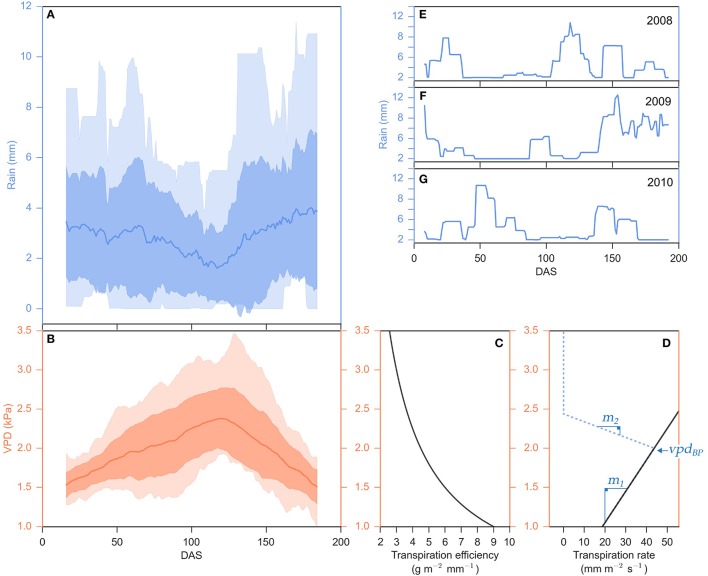
Seasonal fluctuations of rainfall and VPD and their relationship to sorghum transpiration rate and efficiency. (A,B) Distribution of daily rainfall (mm) and daily vapor pressure deficit, VPD, (kPa) over the 2000–2014 cropping seasons in College Station, TX, calculated as a mean of a 30-day sliding window. The mean is plotted as a solid line, the lighter transparent fill is the entire data range (minimums and maximums) and the darker transparent fill is one standard deviation from the mean. (E–G) Distribution of daily rainfall (mm) for the 2008 (E), 2009 (F), and 2010 (G) cropping seasons in College Station, TX, calculated as a mean of a 14-day sliding window. (C) Transpiration efficiency, biomass produced per unit of water transpired (g m−2 mm−2), and (D) a hypothetical transpiration rate (solid black line), the amount of water uptake per unit time (mm m−2 s−2), and their responses to VPD (kPa) are plotted along the x-axes sharing the y-axis of panel (B). VPD-limited transpiration trait parameters {vpdBP, m1, m2} is denoted in blue.